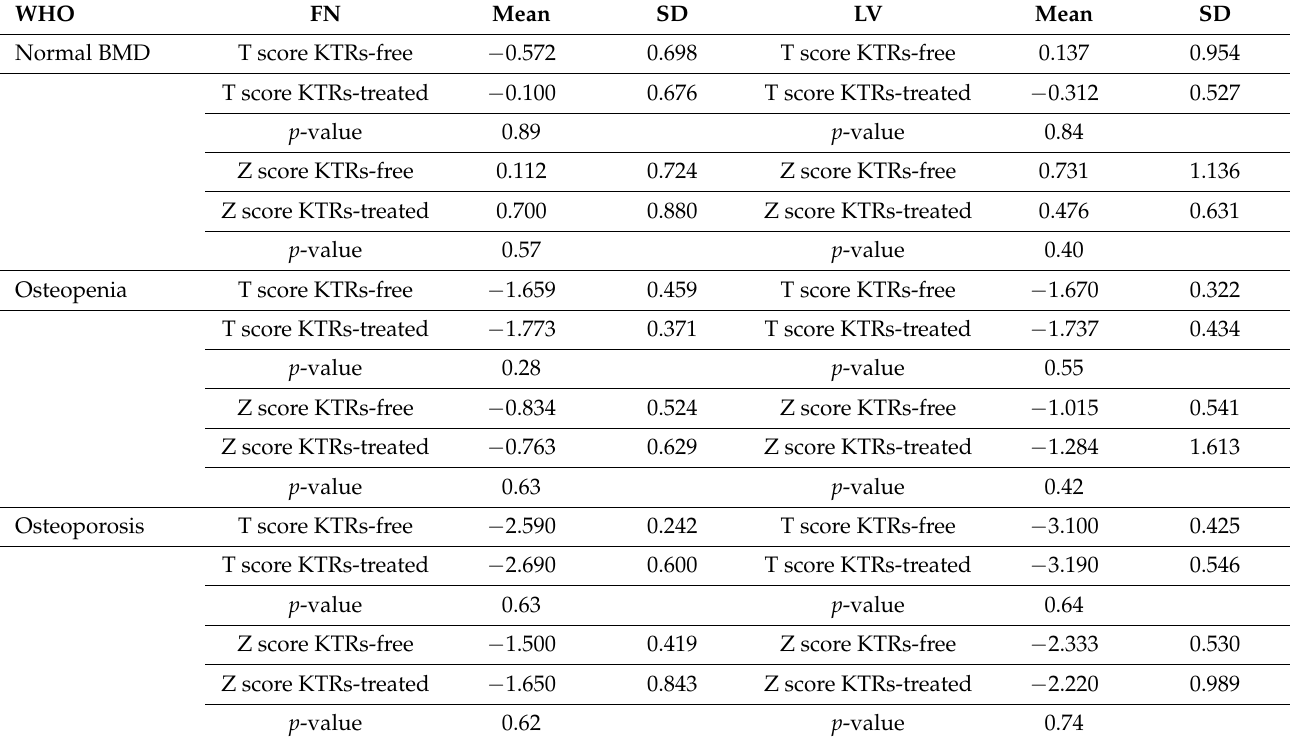
Table 2. DEXA parameters evaluated at the right femoral neck (FN) and lumbar vertebral bodies (LV) according to WHO Classification in KTRs-free and KTRs-treated at